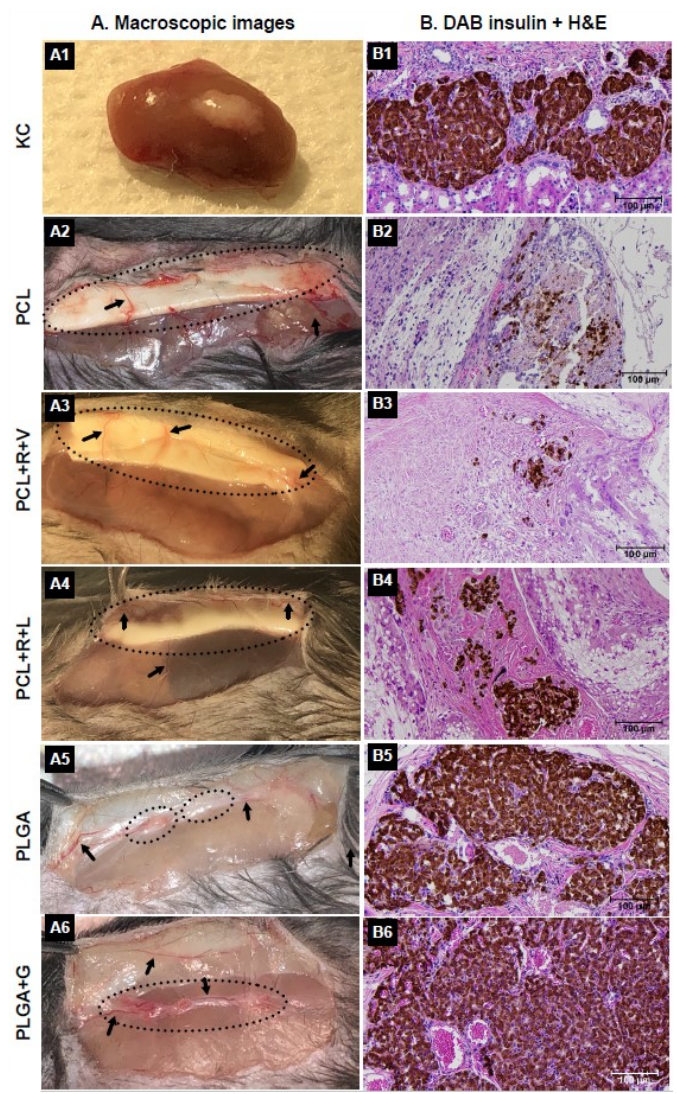
Figure 5. Macroscopic images of KC ( A1 ), PCL ( A2 ), PCL + R + V ( A3 ), PCL + R + L ( A4 ), PLGA ( A5 ) and PLGA + G ( A6 ) grafts at 27 weeks post-transplant. PCL + R + V and PCL + R + L scaffolds were intact and were not absorbed even at 31 weeks post-implantation whereas PLGA and PLGA + G scaffolds disappeared completely (indicated by circle). Interestingly, blood vessel innervations (indicated by arrows) were observed in the subcutaneous scaffolds. Of note, enormous blood vessels were observed in the PLGA and PLGA + G scaffolds. Immunostaining of grafts confirmed the presence of intact islet clusters with robust insulin positive cells (brown) in the KC ( B1 ), or PLGA ( B5 ) and PLGA + G ( B6 ) scaffolds compared to few insulin positive islet clusters in the PCL ( B2 ), PCL + R + V ( B3 ) and PCL + R + L ( B4 ) scaffolds. Of note, distinguishable blood vessels inside the grafts were seen in the PLGA and PLGA + G